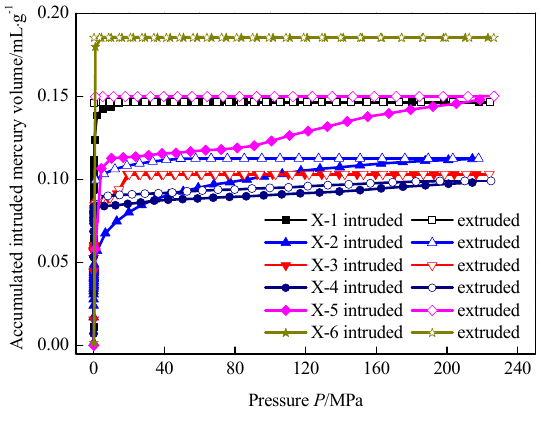
Figure 4. Accumulated intruded/extruded mercury volume versus pressure curves. Table 1. Pore volume distribution.